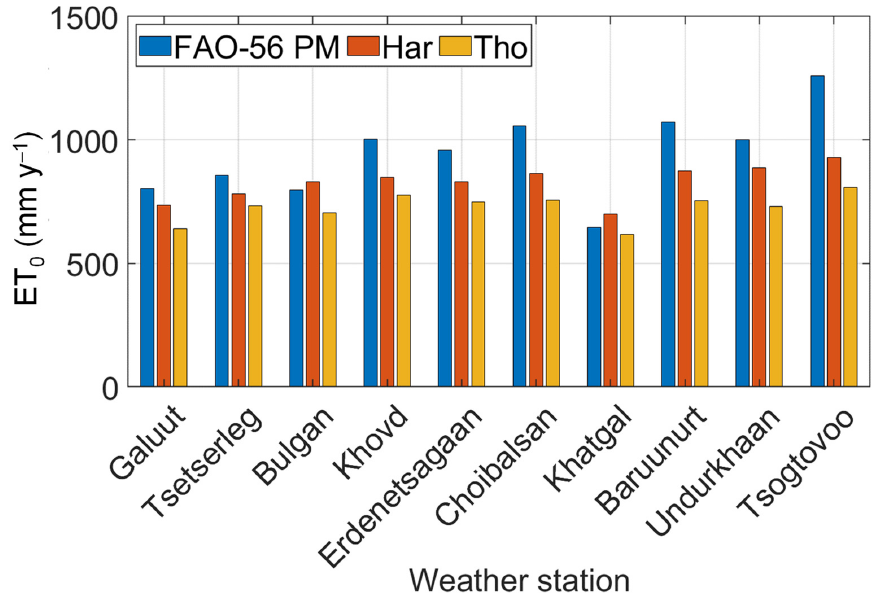
Figure 5. Mean annual grass-reference evapotranspiration, ET 0 calculated with FAO-56 PM (blue bars), Har (orange bars), and Tho (yellow bars) for 10 weather stations in Mongolia.